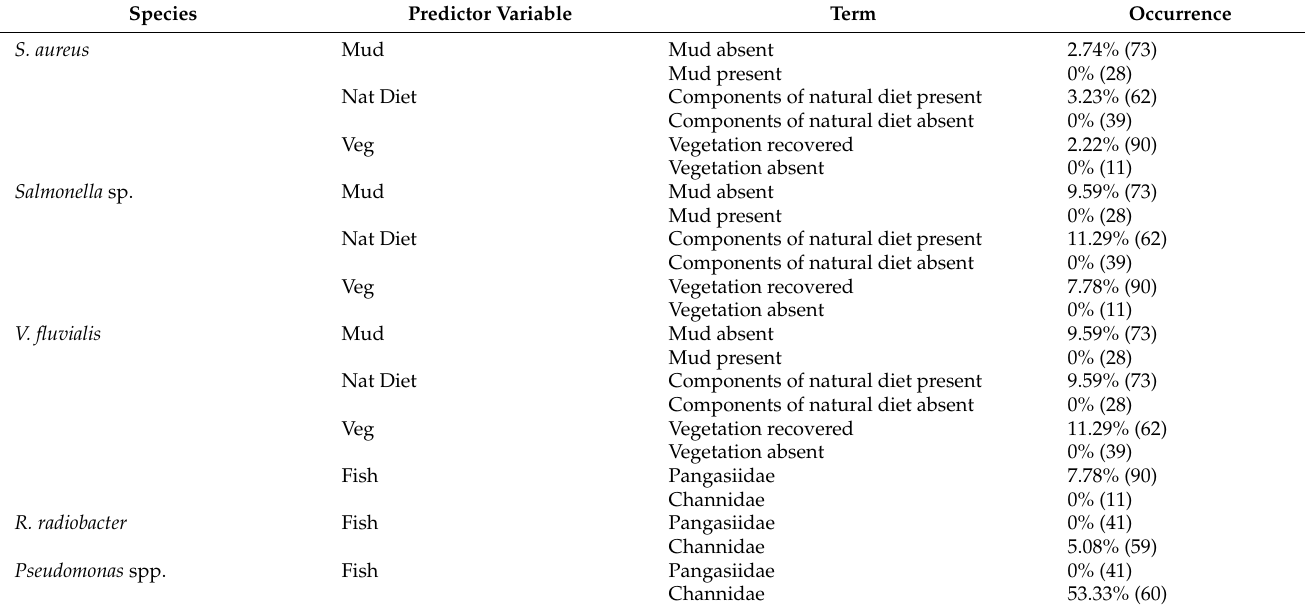
Table 5. Occurrence of bacteria species by predictor variables. Bracketed numbers in ‘Occurrence’ column show the total count of fish from Sp. A (n = 60) and Sp. B. (n = 41). Bag water not included in statistical evaluation. Predictor variables based on supply chain breaches identified in Williams et al. (2021).